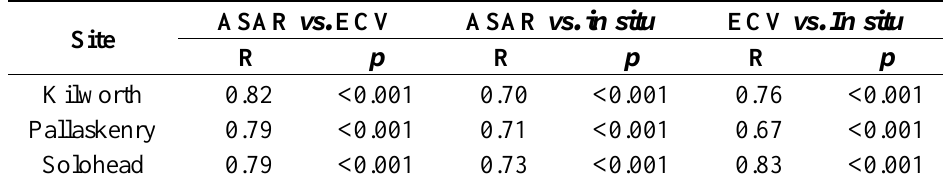
Table 6. Correlation values evaluated between each pair of soil moisture dataset. Correlation levels are all statistically significant ( p -values <